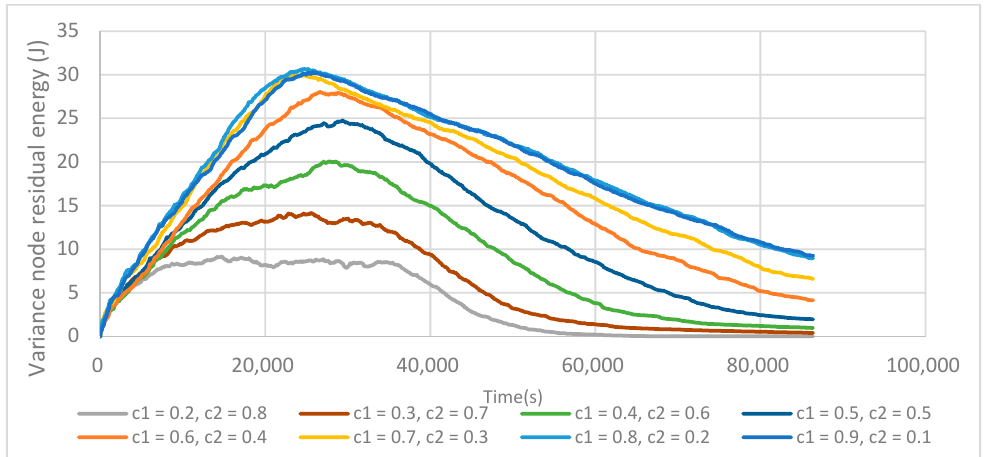
Figure 8. Variance of residual energy depending on C1 and C2. Lowering C2 increases σ E (t) as the residual energy of nodes has less impact on the fCH selection.